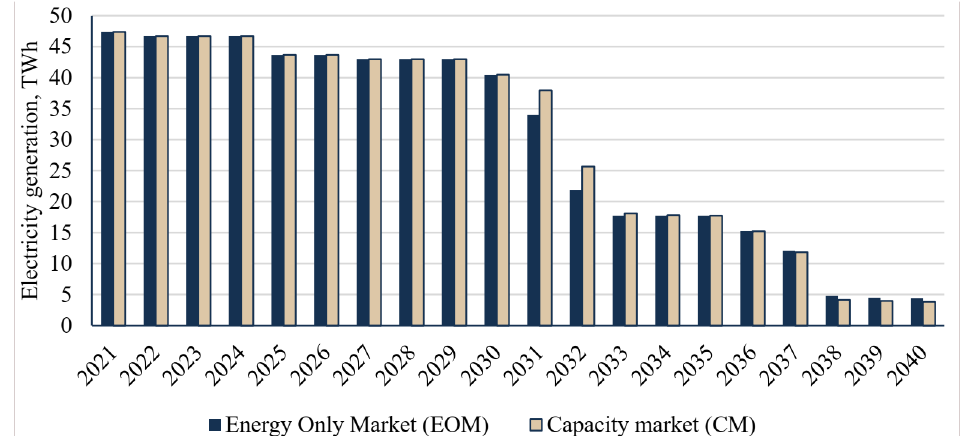
Figure 14. Electricity generation from lignite-fired units under the EOM and CM scenarios in 2021–2040.